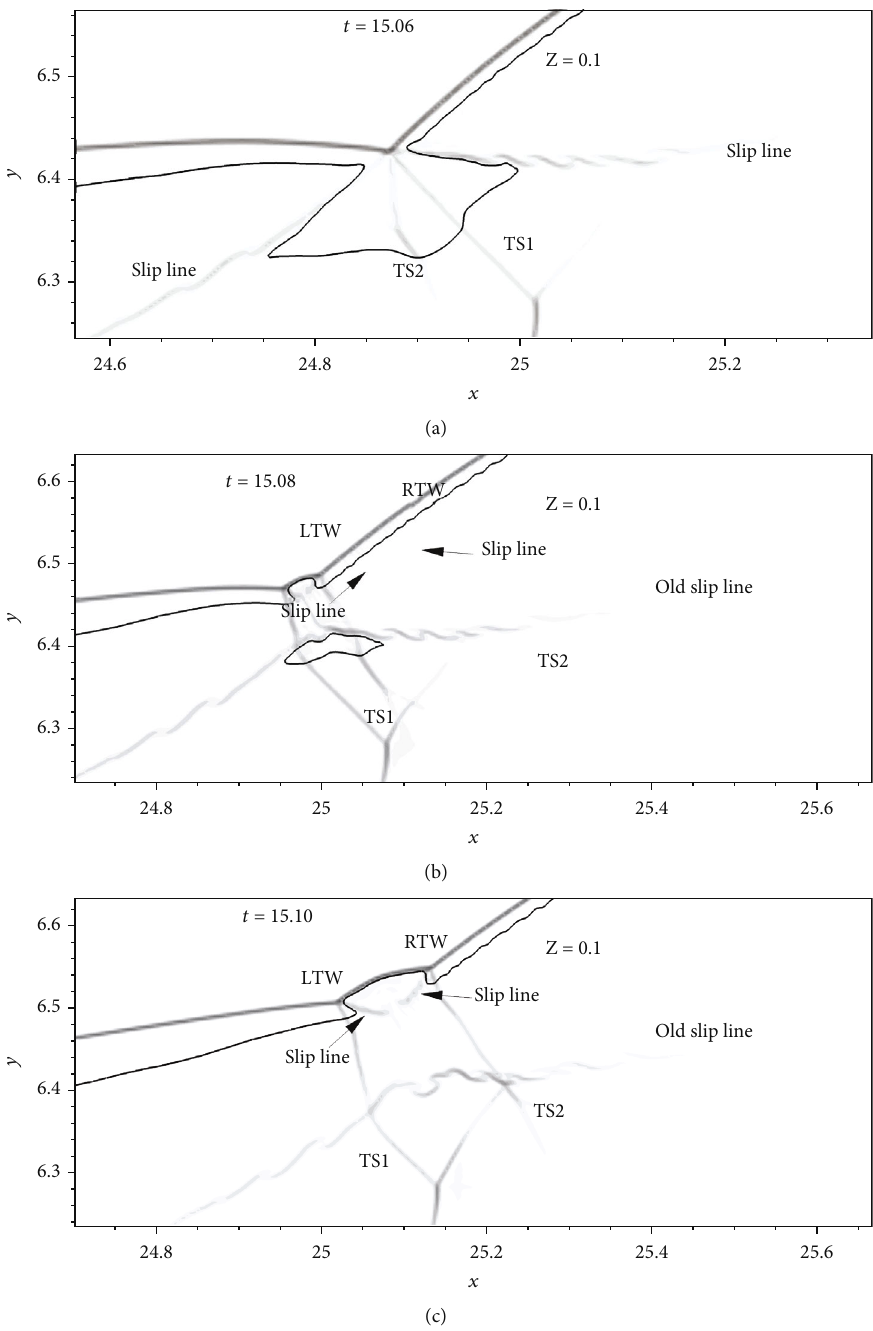
Figure 14: Formation of an unreacted region behind the cellular oblique detonation. (a) t = 15 : 06 . (b) t = 15 : 08 . (c) t = 15 : 10